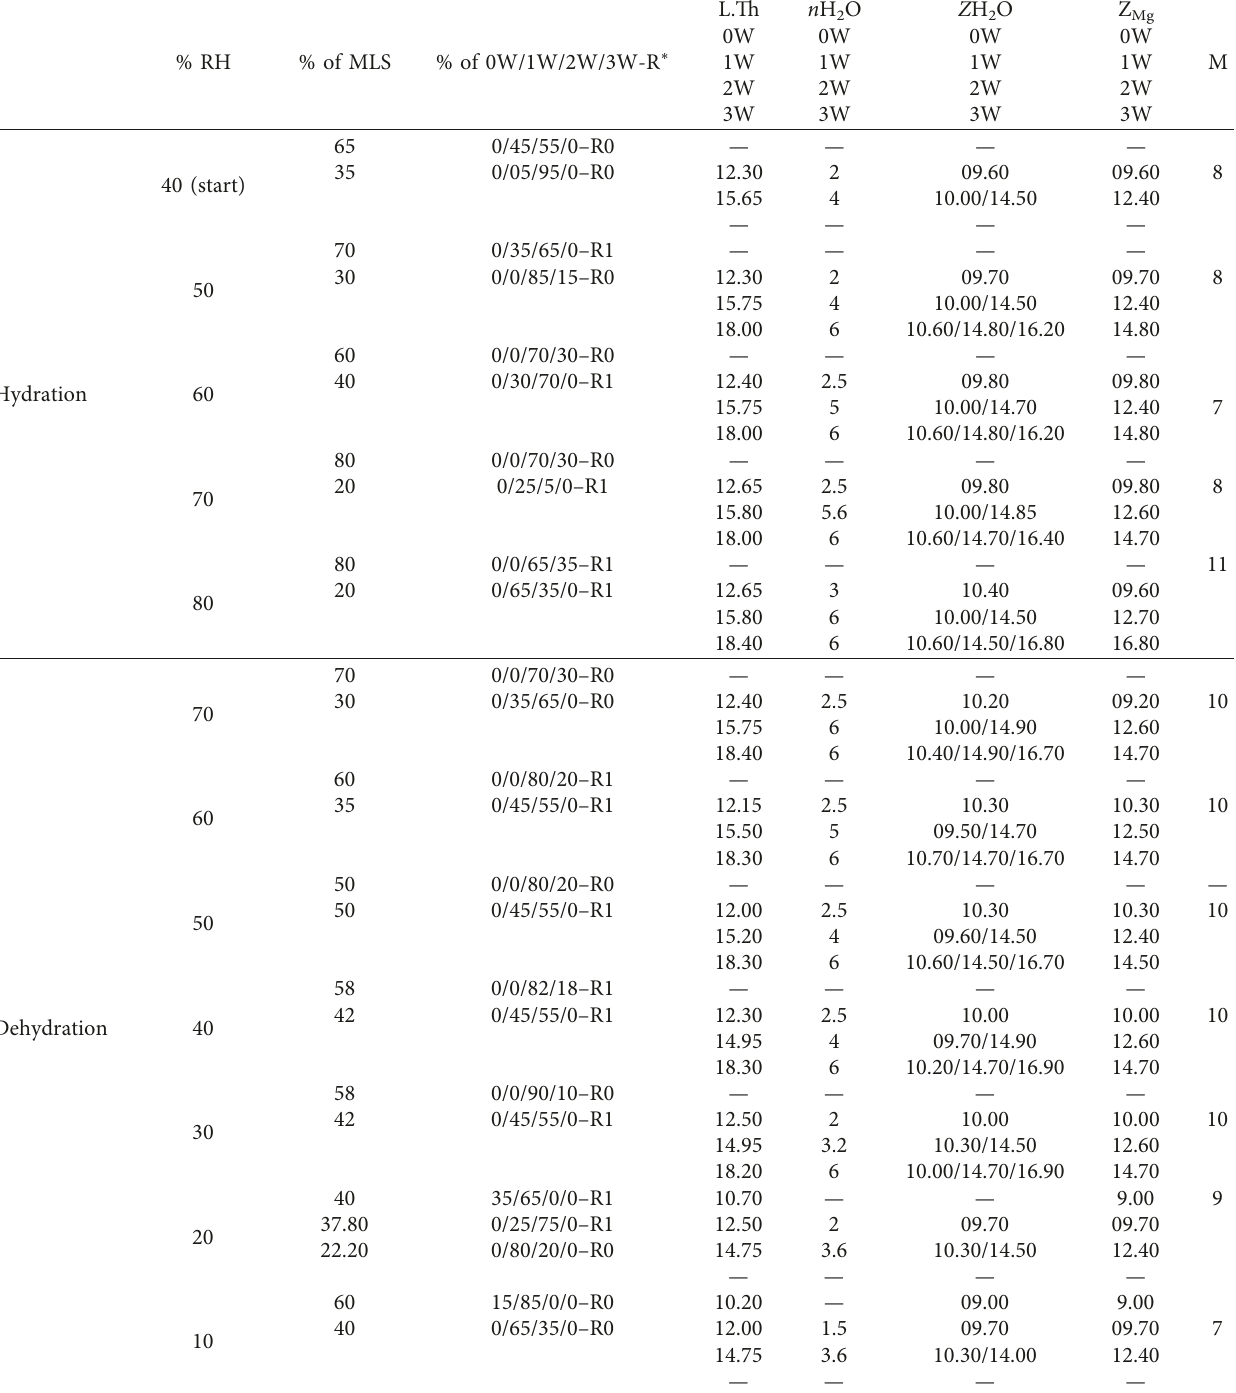
Table 2: Structural parameters used to reproduce experimental patterns of SWy-2-Mg complex as a function of RH along the first hydration-dehydration